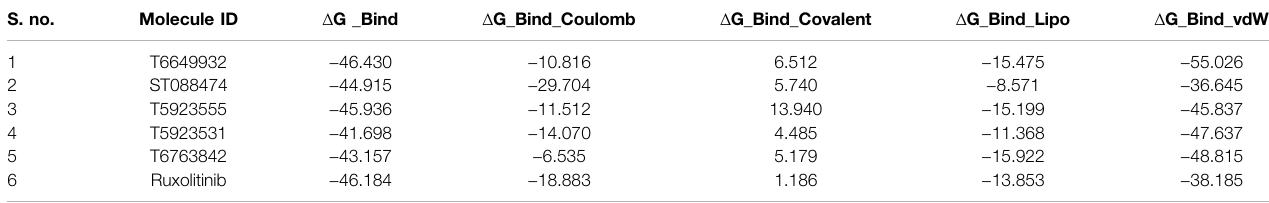
TABLE 8 | MM-GBSA results of the selected JAK1 lead compounds and the drug. S. no.